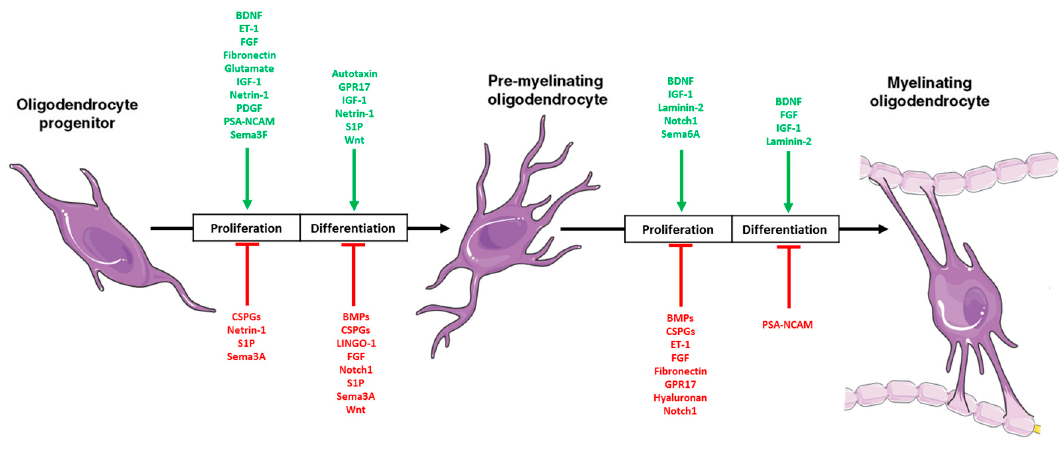
Figure 4. Schematic representation of the generation of mature, myelinating oligodendrocytes. A precise balance with epigenetic regulation of differentiation activators and inhibitors of extracellular cues promoting (green) and/or inhibiting proliferation (red) and/or differentiation at different stages of oligodendrogenesis. Modified from [88].